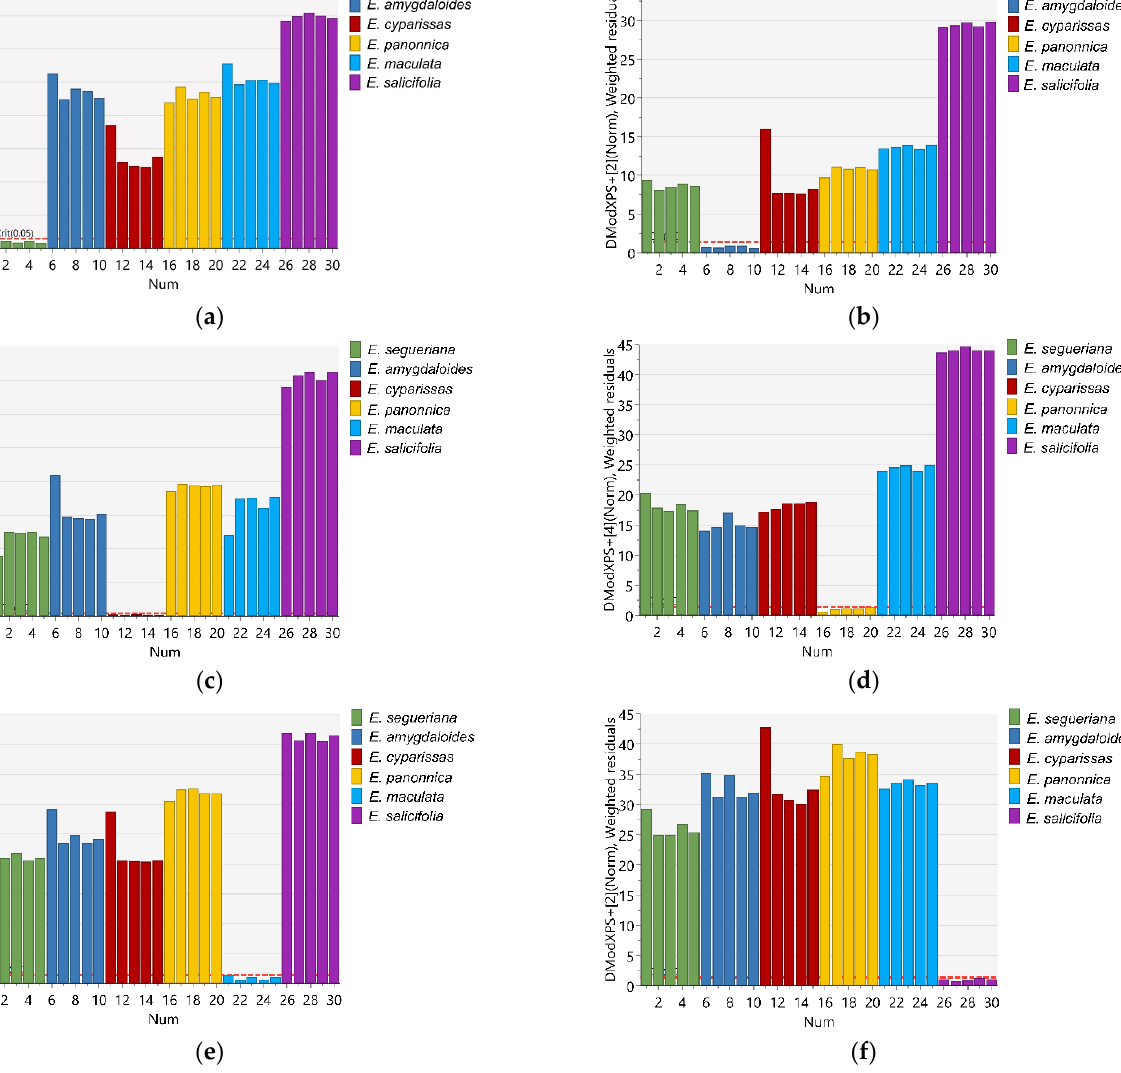
Figure 3. Logarithmic averaged distance to the models of ( a ) E. segueriana, ( b ) E. amygdaloides, ( c ) E. cyparissias, ( d ) E. panonnica, ( e ) E. maculata and ( f ) E. salicifolia vs. remaining Euphorbia species.